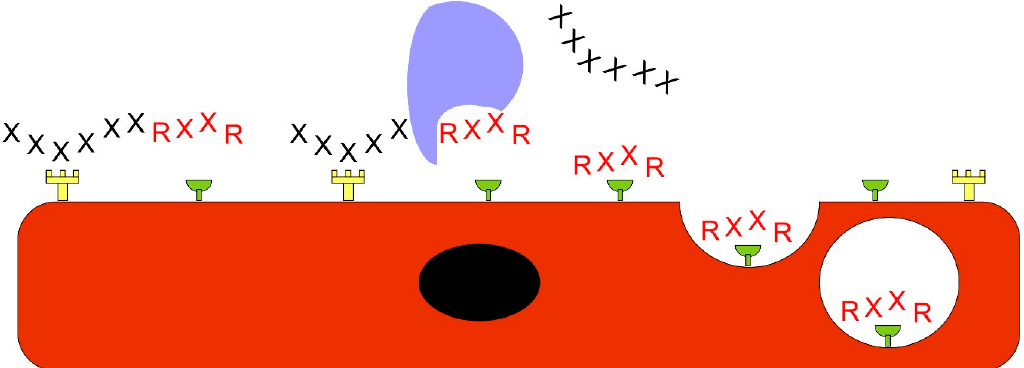
Figure 5. The function of the C-end Rule sequence. Peptides containing the C-end Rule (CendR) sequence are capable of penetrating to tissues and delivering cargo. Typically, the CendR sequence is cryptic and needs to be exposed. The receptor specific for the target tissue (fork) first binds the homing peptide enabling its cleavage by an enzyme (blue), which results in the exposure of the CendR sequence (RXXR). The CendR sequence then binds to another receptor (half a circle), neuropilin-1 (NRP-1), which triggers the cell membrane to form a vesicle containing the peptide and other molecules close to it. The vesicle is then transferred through the cell to let its contents enter to the tissue parenchyma.